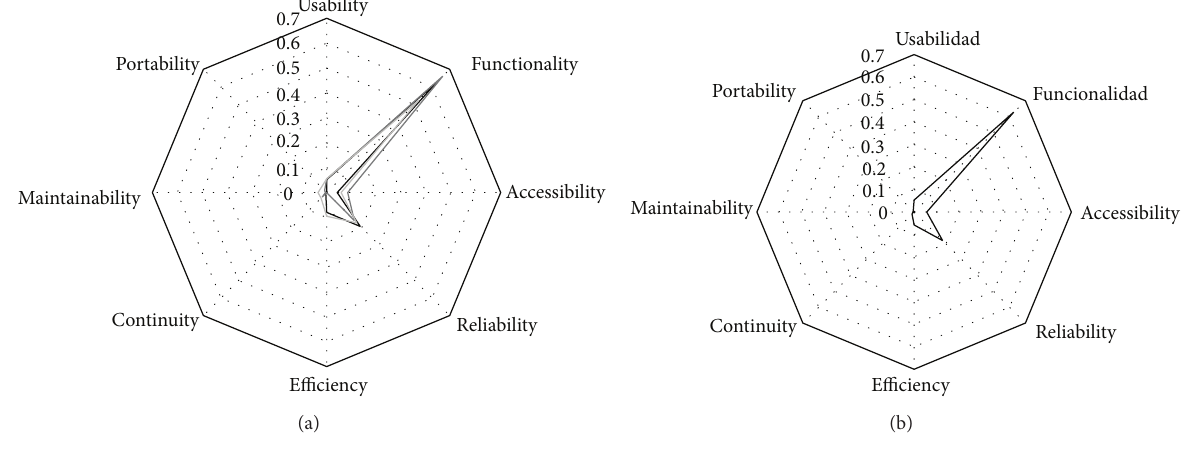
Figure 2: Internal/External Quality.